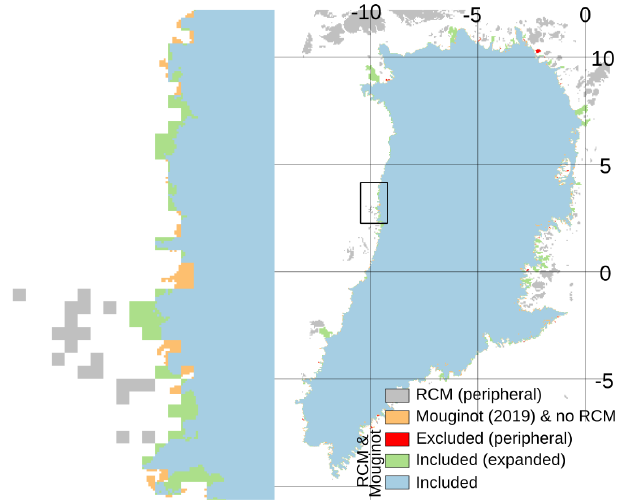
Figure E1. HIRHAM RCM coverage by Mouginot and Rignot (2019). Coverage of HIRHAM by Zwally et al. (2012), and MAR and RACMO by Mouginot and Rignot (2019) and Zwally et al. (2012) are similar to the graphic shown here (see Sect. 5.5 for a discussion of RACMO coverage issues). HIRHAM latitude and lon- gitude cover the Equator because we work on the native HIRHAM rotated pole coordinate system.